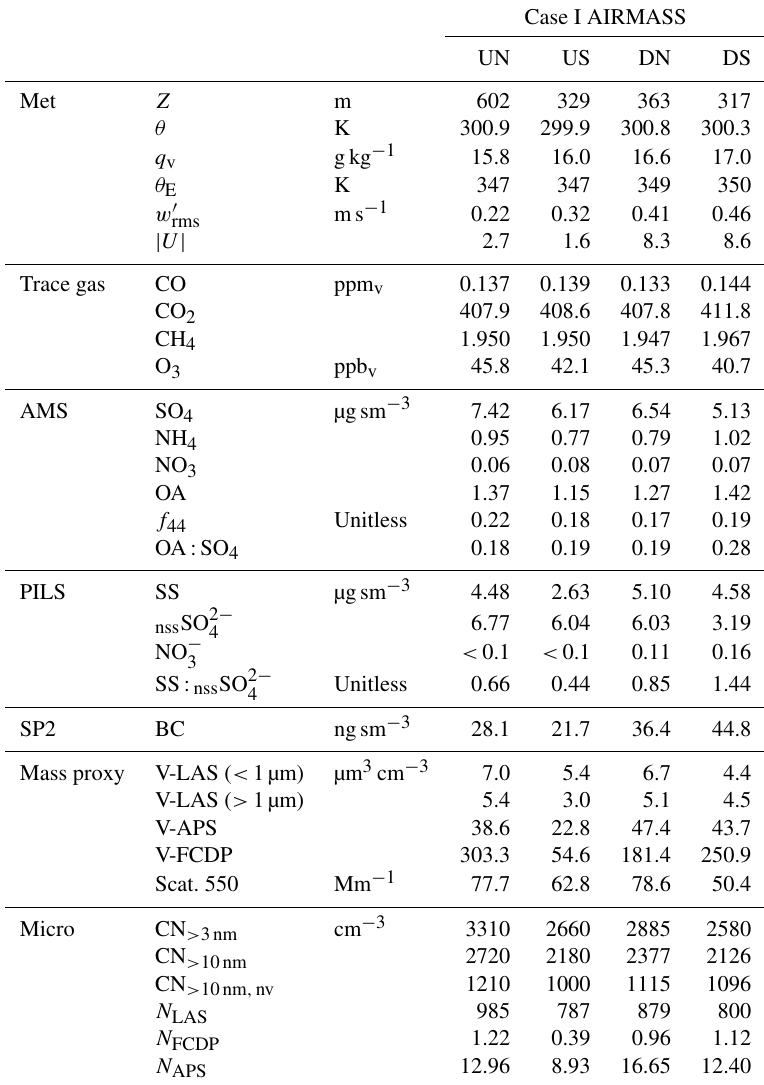
Table 2. Case I sub-cloud air-mass properties pertaining to the upwind northern and southern (UN, US) and downwind northern and southern (DN, DS) quadrants surrounding the convective